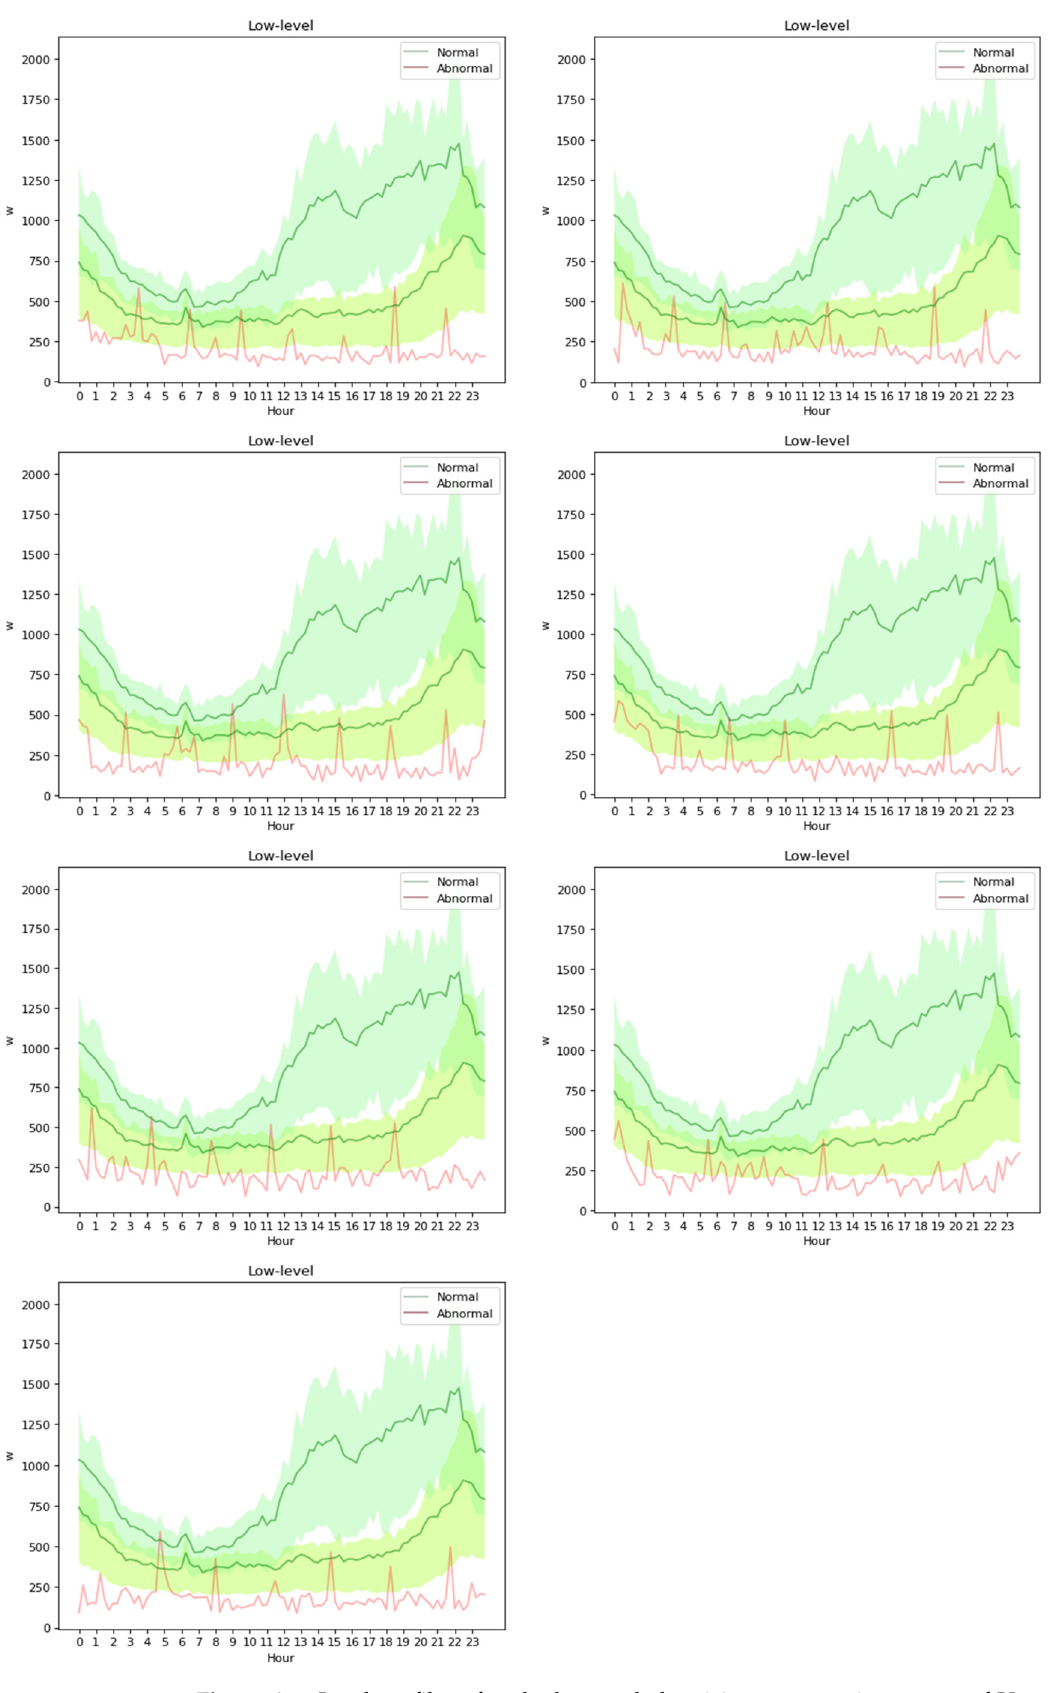
Figure A3. Load profiles of each abnormal electricity consumption events of User 02 using the low-level features.